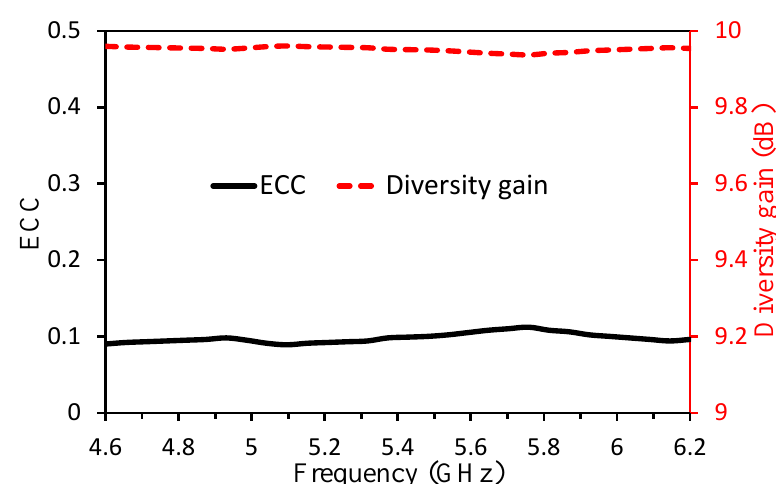
Figure 8. ECC and diversity gain of the antenna.